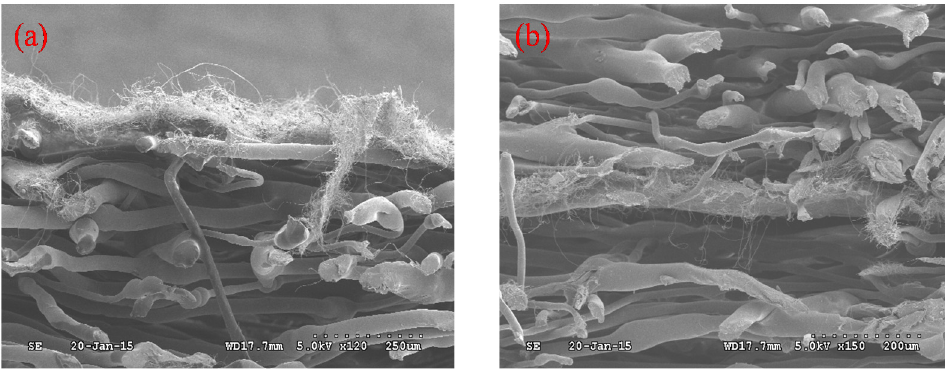
Figure 4. SEM images of ( a ) PAN nanofiber air filter A; and ( b ) PAN nanofiber air filter B.